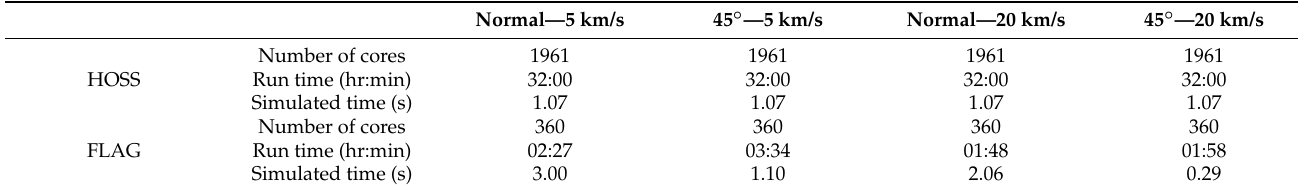
Table 2. Computational resources required for the 3D impact